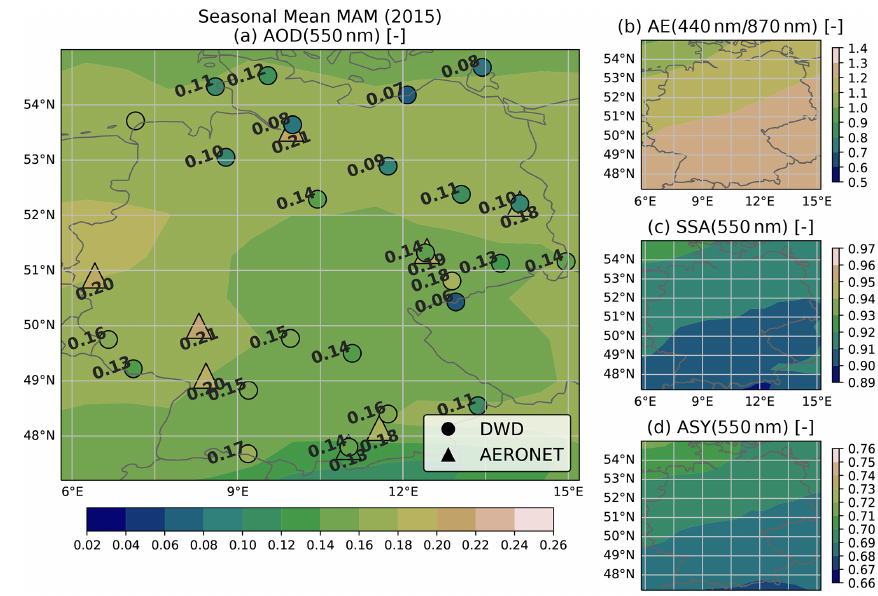
Figure D4. As Fig. 11 but showing the average over winter 2015.